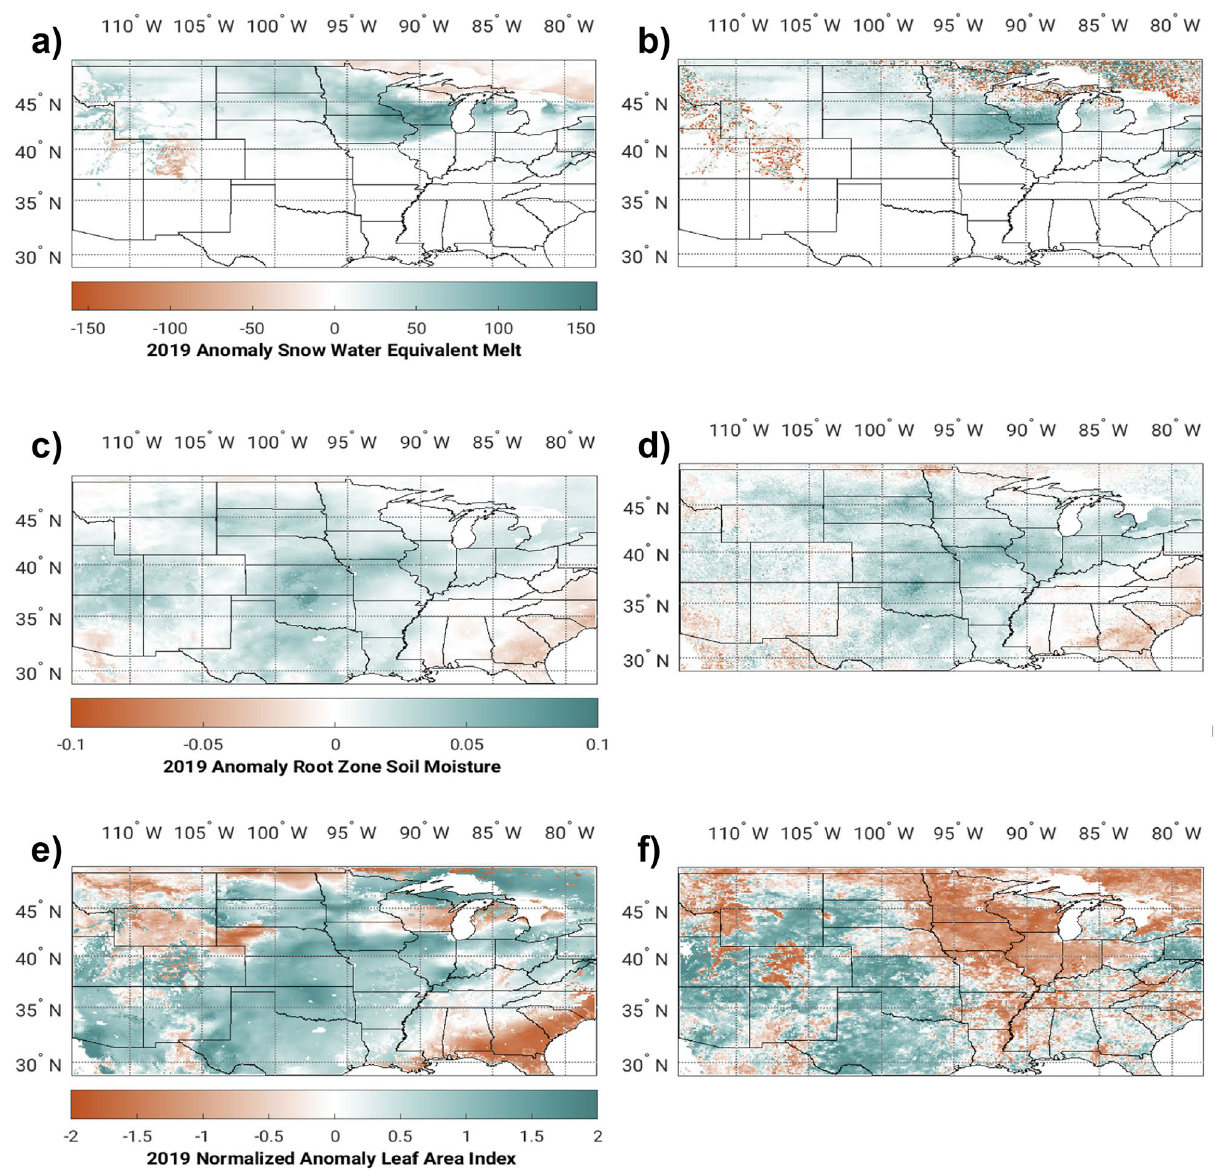
Figure 4. Spatial Extent of Modeled 2019 Mississippi Basin anomalies compared to averages from 2016 to 2020. Snow melt anomalies (10 March–29 March) from the LIS-OL simulation ( a ), snow melt anomalies (10 March– 29 March) from the LIS-DA simulation ( b ), soil moisture anomalies (1 May–1 July) from the LIS-OL simulation ( c ), soil moisture anomalies (1 May–1 July) from the LIS-DA simulation ( d ), LAI standardized anomalies (1 June–1 July) from the LIS-OL simulation ( e ), and LAI standardized anomalies (1 June–1 July) from the LIS-DA simulation ( f ) are plotted. The color bars for the OL simulations (left) are the same as for the DA simulations (right). Map panels were generated by Matlab version DA (right) simulations. Both simulations show a significant area of anomalously high snowmelt near the Corn Belt area; however, the OL solution has more snowmelt than is depicted in the University of Arizona observa- tions (shown in Fig. 2c). The multivariate DA simulation has reduced high bias, and the snowmelt extends further west towards Nebraska, as in the observations. We also compared spatial similarity between modeled and observed SWE melt using the structural similarity index (SSIM) 52 . SSIM between UA observations and the LIS-OL simulation is 0.42, which increases to 0.44 with multivariate DA. Note that a gaussian smoother with a sigma value of 2 was applied to the data to remove discontinuities in the data fields before computing SSIM. Soil moisture anomalies for May and June 2019 are shown in Fig. 4c,d, and this Figure shows (as in Fig. 3) that the multivariate DA simulation has more pronounced soil moisture anomalies over the Corn Belt compared to the OL solution. The added value of DA is best realized by comparing the standardized LAI anomalies in Fig. 4e,f to the change in crop fraction in Fig. 2e, as the losses of corn and soil crops shown in Fig. 2e mostly follow the negative LAI anomalies in the multivariate solution in Fig. 4f. The SSIM between the LAI standardized anomalies